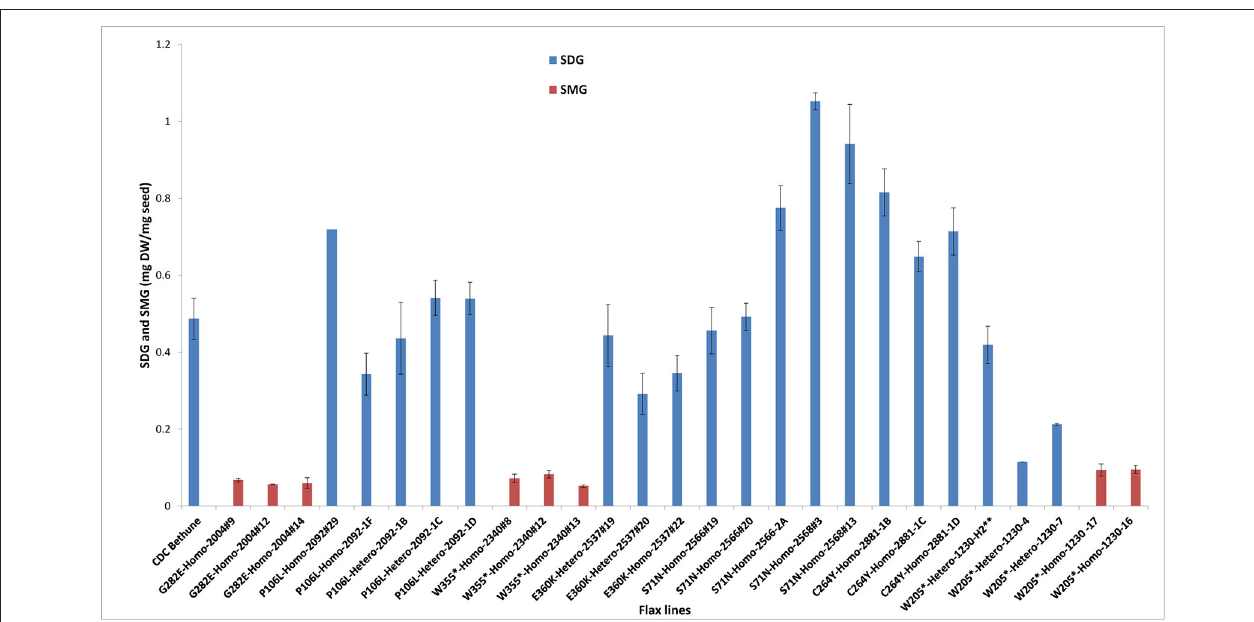
FIGURE 5 | Variations in SDG and SMG lignan contents in M3 and M4 seeds from EMS mutagenized flax lines following lignan complex hydrolysis. SDG and SMG UPLC peaks were monitored using mass spectra and quantified. EMS lines are named as EMS-induced amino acid changed followed by the homo or heterozygous status and the line number. Single asterisk (*) indicates premature stop codon. The profile of M3 seeds derived from M2 line 1230-H2 is indicated by a double asterisk (**). Lignan was extracted from CDC Bethune and from M4 seeds derived from their respective M3 plants.